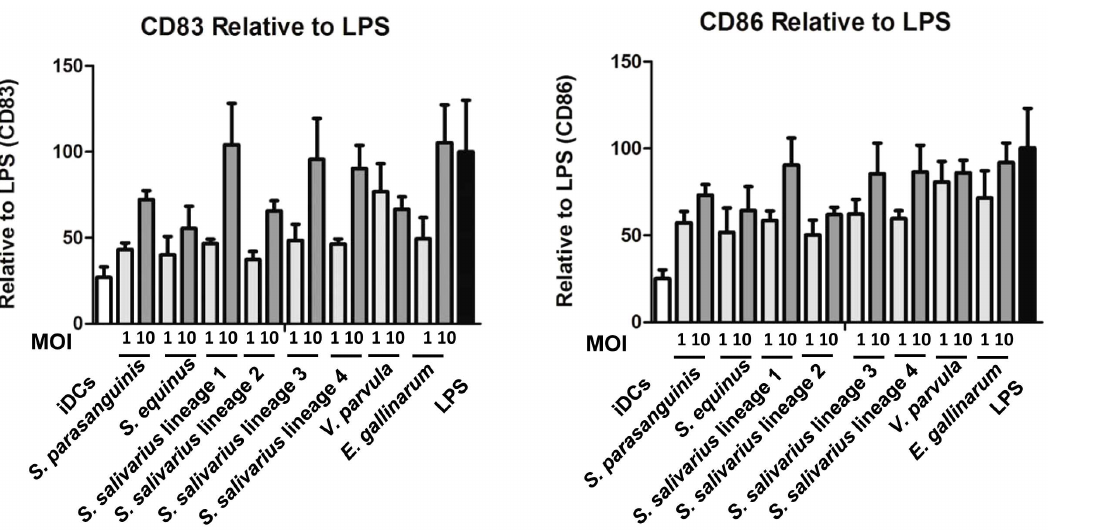
Figure 1. MFI of stained cell surface markers CD83 (A) and CD86 (B) by monocyte derived dendritic cells. Immature DCs were used as the negative control and LPS as the positive control. Dendritic cells were derived from monocytes of 5 different human